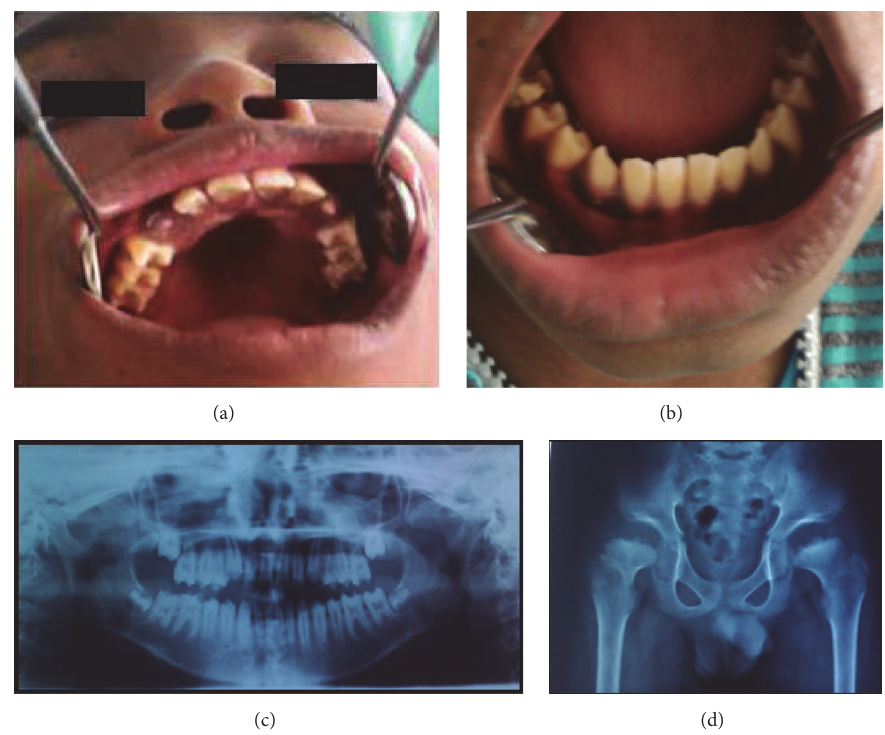
Figure 2: (a), (b) Spade-shaped incisors, pointed cusps, and spacing between teeth in both maxillary and mandibular teeth in case 2 . (c) Orthopantomograph showing thin enamel with normal radio density. (d) Pelvic radiograph showing shallow acetabula and square-shaped femoral head in case 2